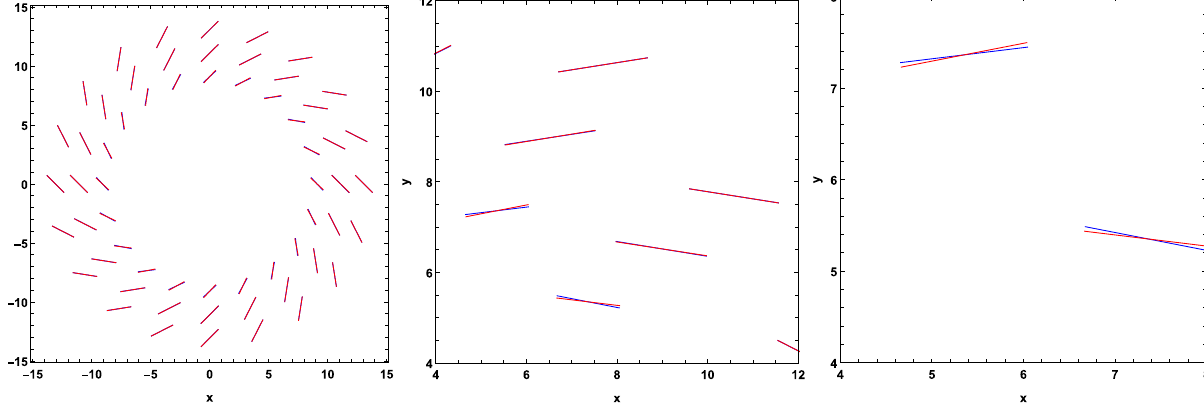
secondary image decreases with α for the PPL and increases for the PPM. Moreover, the bright region in the image with the inclination angle θ o = 70 ◦ caused by the PPL extends to both sides along the black boundary and the disk’s image in the high latitude zone shrinks. In the image caused